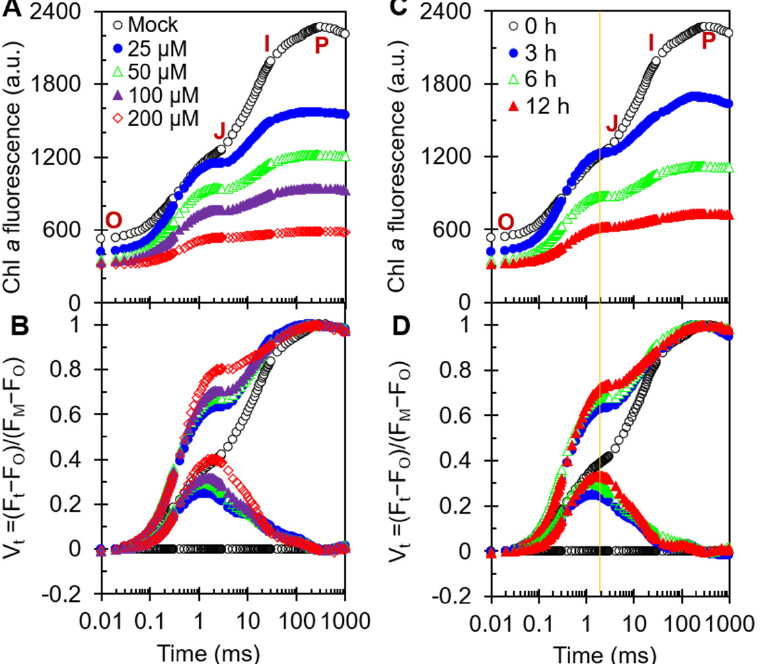
Figure 3. Effects of cytochalasin A on fast chlorophyll a fluorescence rise kinetics OJIP of A. adenophora leaf discs. ( A , B ) Raw Chl a fluorescence rise kinetics and its variable changes normalized by F O and F M as V t = (F t − F O )/(F M − F O ) (top) and ∆ V t = V t(treatment) − V t(control) (bottom) in a logarithmic time scale of A. adenophora treated with different concentrations (0, 25, 50, 100 and 200 µ M) of cytochalasin A for 12 h. ( C , D ) Raw Chl a fluorescence rise kinetics and its variable changes normalized by F O and F M as V t = (F t − F O )/(F M − F O ) (top) and ∆ V t = V t(treatment) − V t(control) (bottom) in a logarithmic time scale of A. adenophora treated with 50 µ M cytochalasin A for different time periods (0, 3, 6 and 12 h). Each curve is the average of three independent experiments with around 15 repetitions.